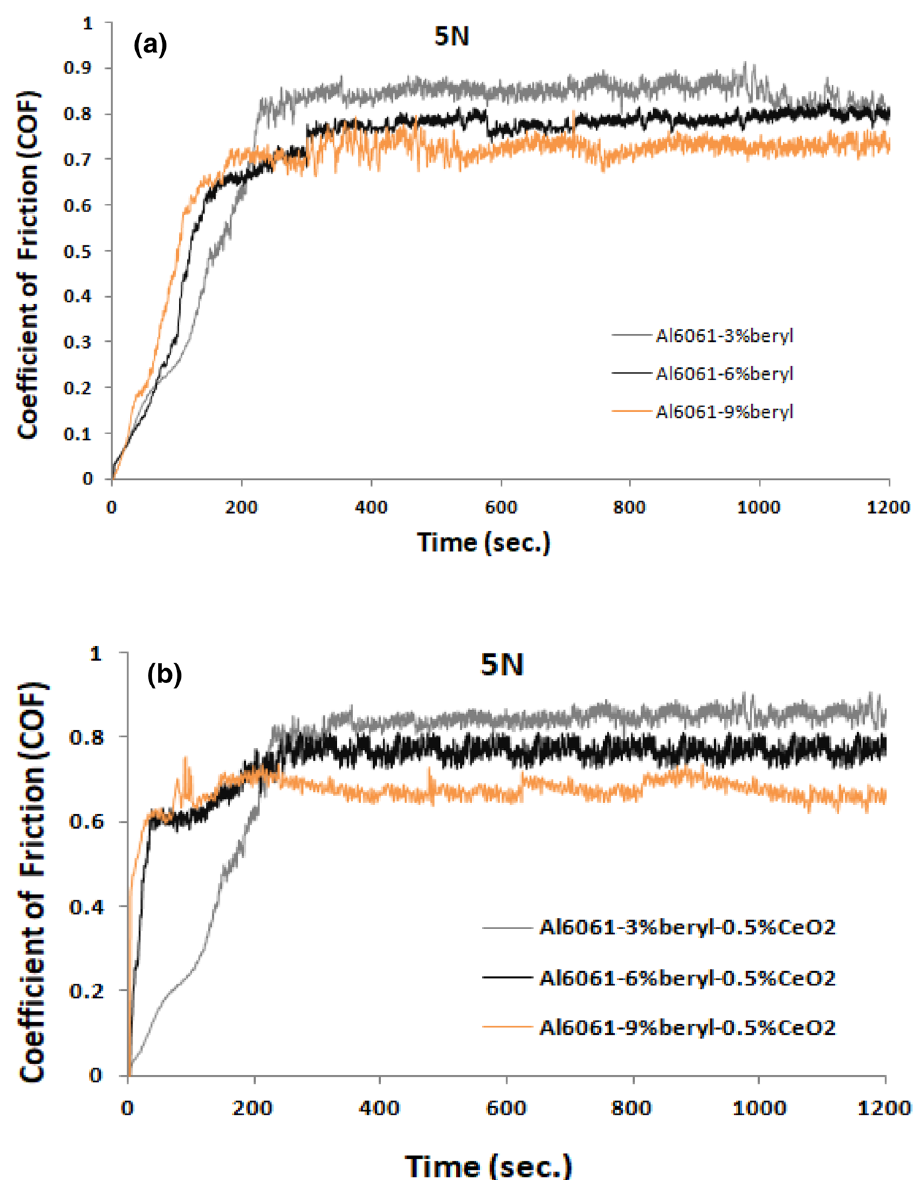
Fig. 5 Typical plots of COF as a function of time for “Al6061– Beryl” composites worn against steel ball in air with and with‑ out CeO